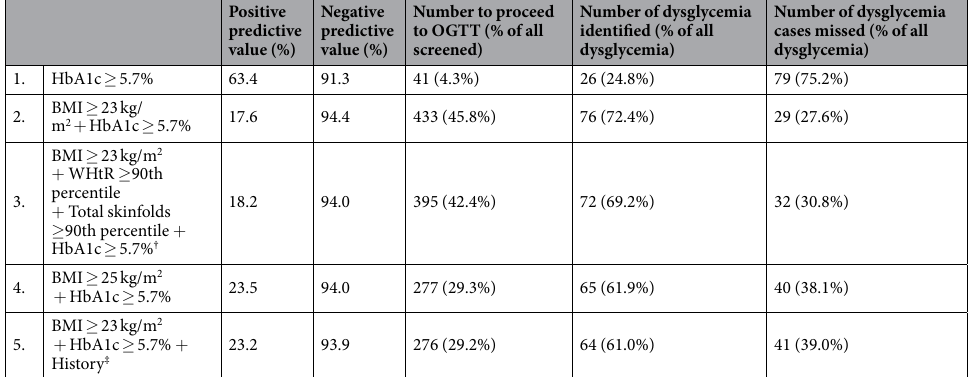
Table 3. Clinical utility of different strategies in detecting dysglycemia preconception among 946 Asian women who provided both BMI and HbA1C measures (105 out of 946 women with HbA1c measure had dysglycemia). † n = 932 provided all measurements (104 out of 932 women with dysglycemia). ‡ History variables included: Age ( > 30 years), ethnicity, educational level, smoking history, shift work, menstrual cycle regularity, parity, GDM history, and family history of